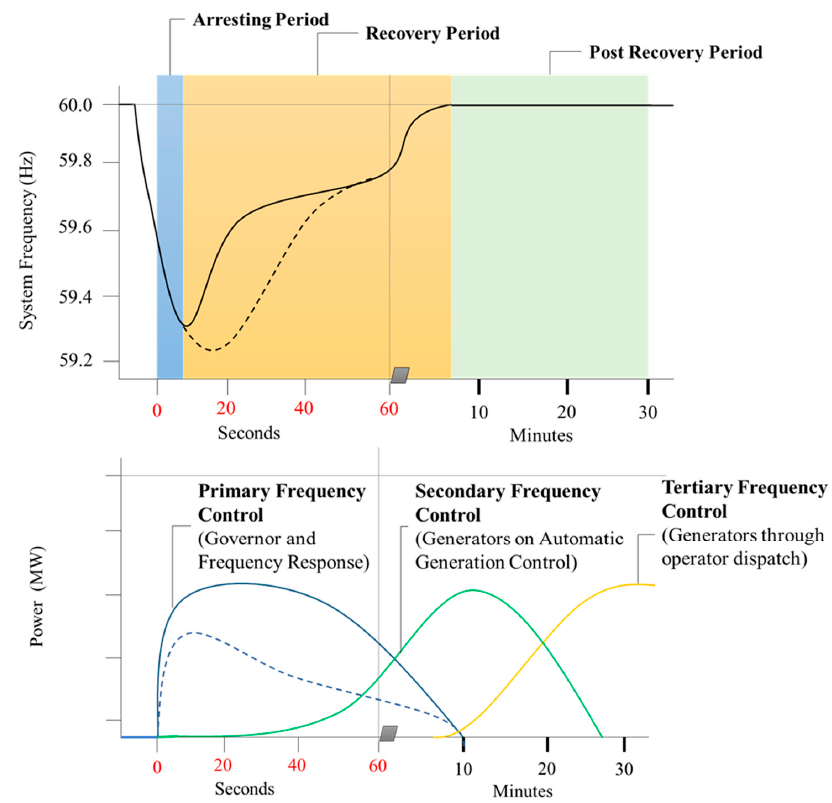
Figure 1. Feature of frequency response.